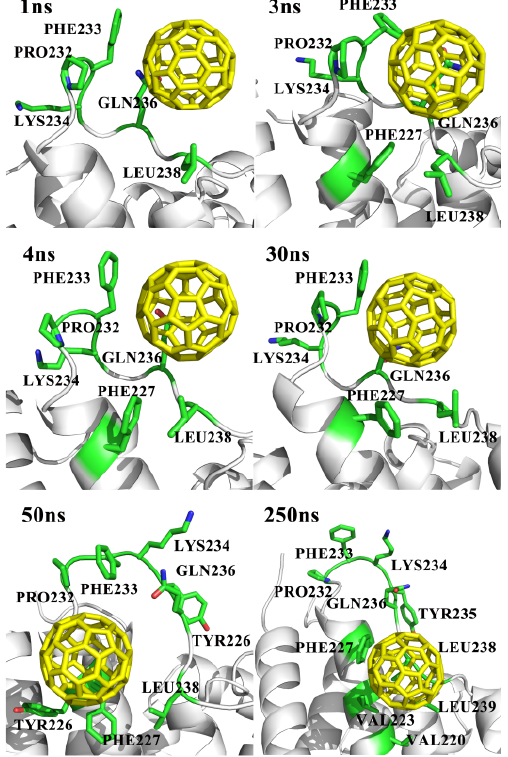
Figure 6. Snapshots of the system C 60 _in1 at different simulation times show that the key amino acids such as the PRO232, PHE233, LYS234, GLN236 and LEU238 interacted with the monomeric fullerenes at the extracellular and intracellular sides.